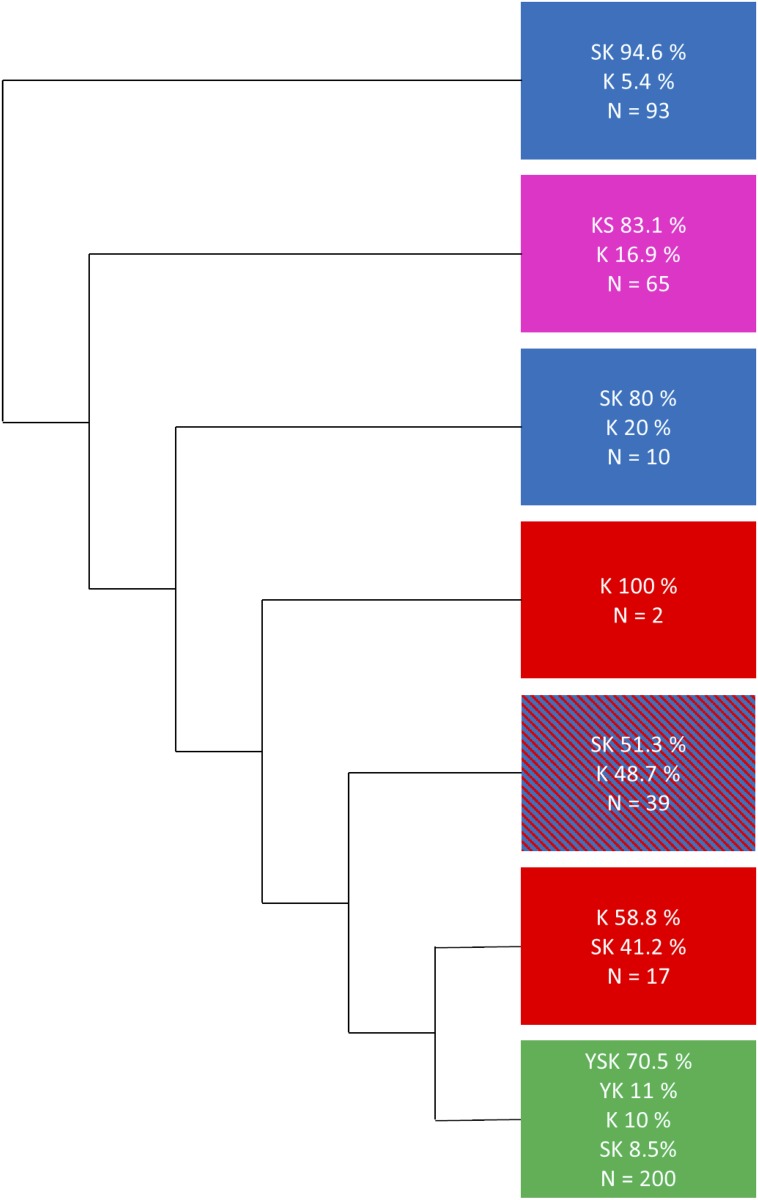
Simplified phylogenetic tree showing the major dehydrin architecture clusters.The phylogenetic tree in S1 Fig was reduced into clusters by visual inspection in order to minimize the number of clusters while trying to generate clusters that were enriched with just one architecture type. The colors represent the major architecture present in each cluster; red for Kn dehydrins, magenta for KnS dehydrins, blue for SKn dehydrins, and green for YnSKn dehydrins.